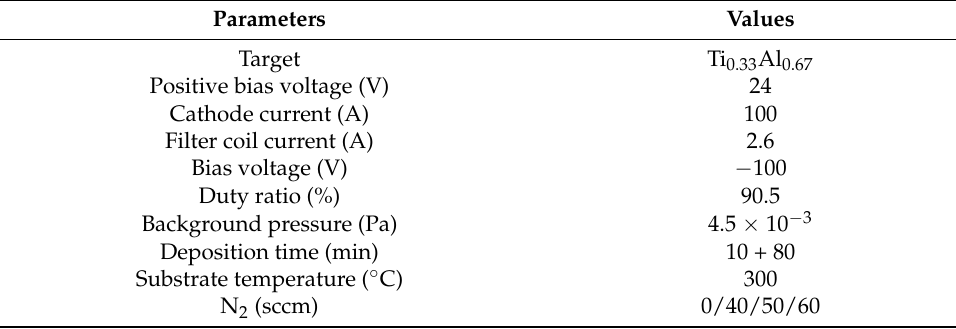
Figure 1. Schematic diagram of the FCVA deposition system. Table 1. Detailed deposition parameters of the TiAlN coatings.